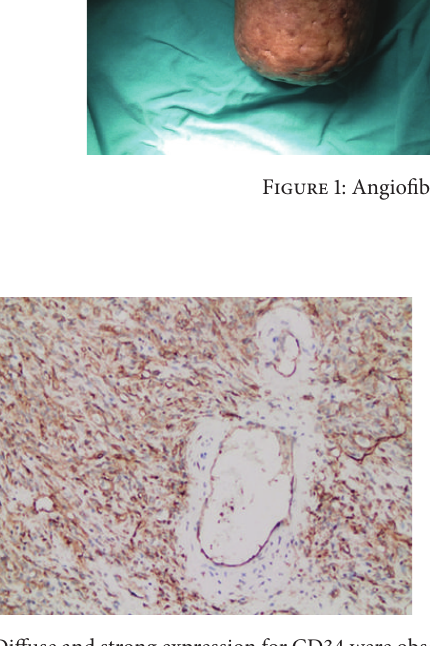
Figure 2: Diffuse and strong expression for CD34 were observed in cytoplasm of spindle-shaped tumor cells. CD34 ×